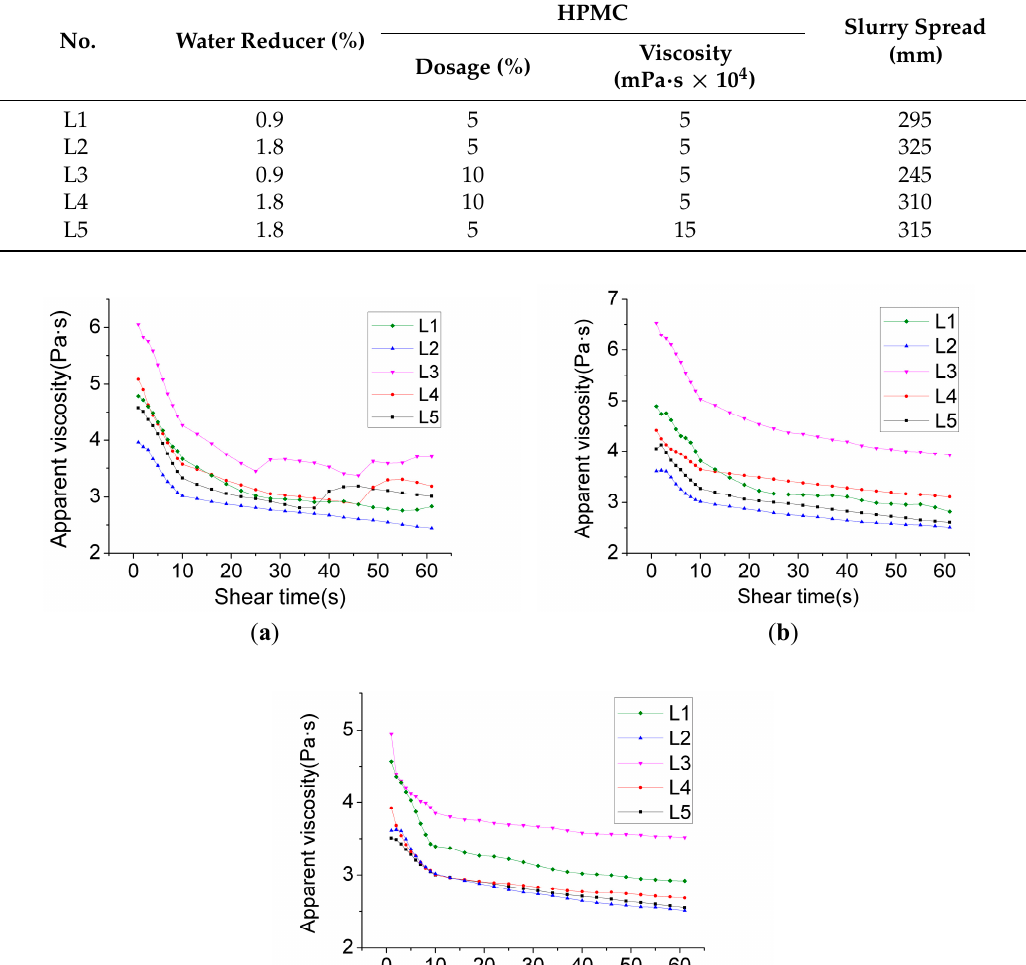
Table 6. The result of the slurry spread.